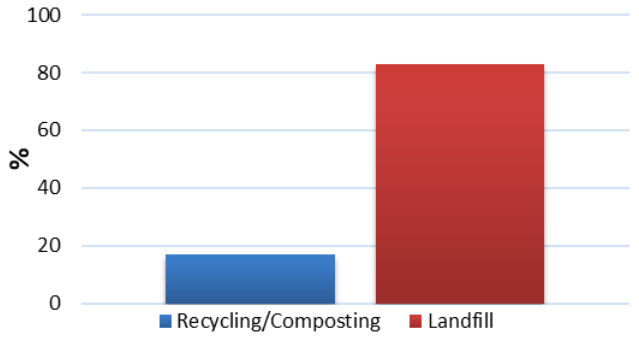
Figure 6. Solid Waste Management (SWM) practices in hotels in Tunisia.